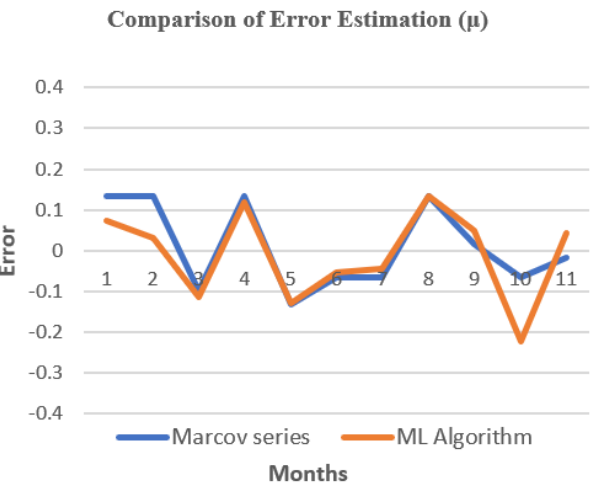
Figure 15. Comparison of errors of the forecasted PDF parameter µ , using Markov series and the implemented algorithm.